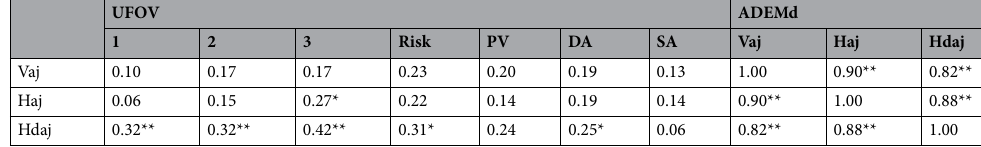
Table 3. Spearman correlation coefficients among the adjusted times obtained with the ADEMd test and the results obtained with the UFOV test in a subsample of 75 subjects. *p < 0.05; **p < 0.01. Vaj vertical adjusted time, Haj horizontal adjusted time, Hdaj horizontal distractor adjusted time, PV processing velocity, DA divided attention, SA selective attention, UFOV useful field of view test, ADEMd Adult Developmental Eye Movement test with